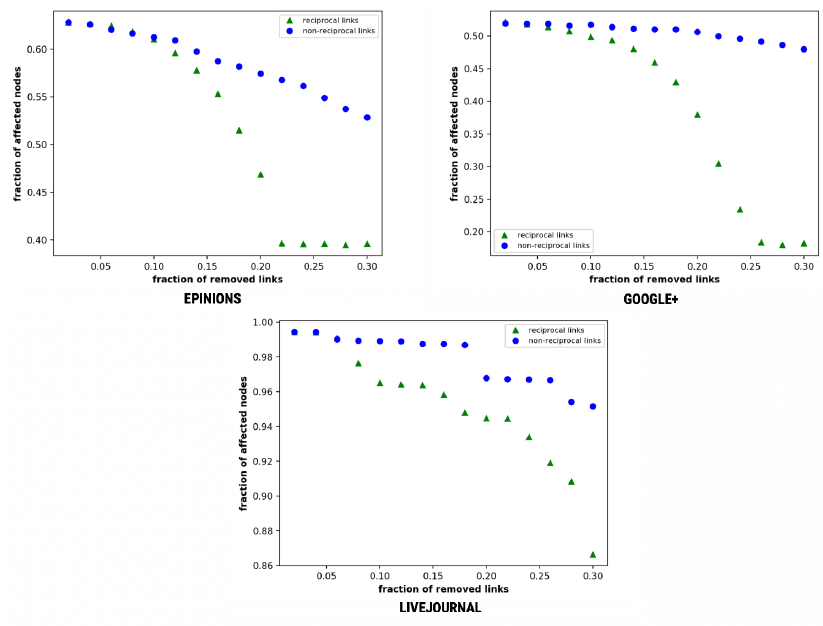
Figure 5. Dynamic diffusion—fraction of affected nodes as a function of the fraction of removed links.